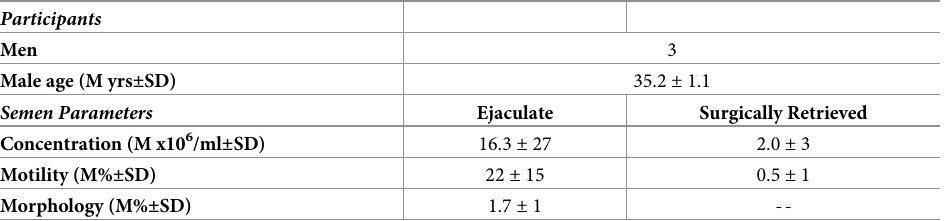
Table 3. Characteristics of sperm specimens from different origin obtained from the same men and screened by FISH and NGS.